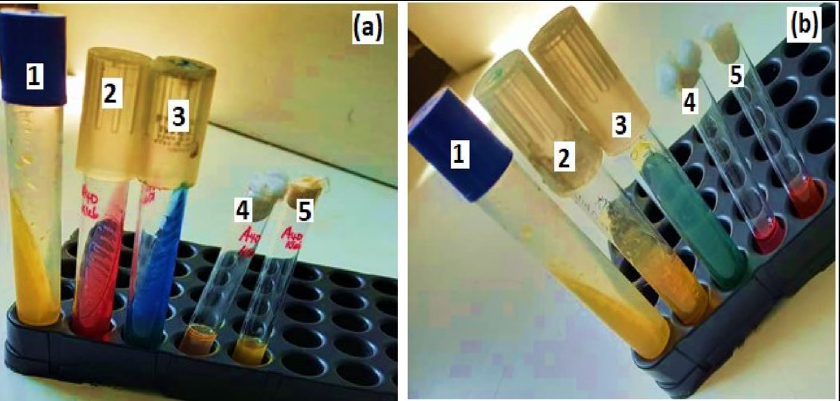
Figure 5. Representative plates for the biochemical phenotypes observed during characterization of bacteria isolated from commercial herbal medicines in Kampala city. ( a ) Panel for K. pneumoniae : 1: TSI(A/A), 2: urease (positive reaction)., 3: citrate utilization test (positive reaction), 4: peptone water for Indole (negative reaction), 5: methyl red test (negative reaction). ( b ) Panel for E. coli : TSI(A/A), 2: urease (negative reaction), 3: citrate